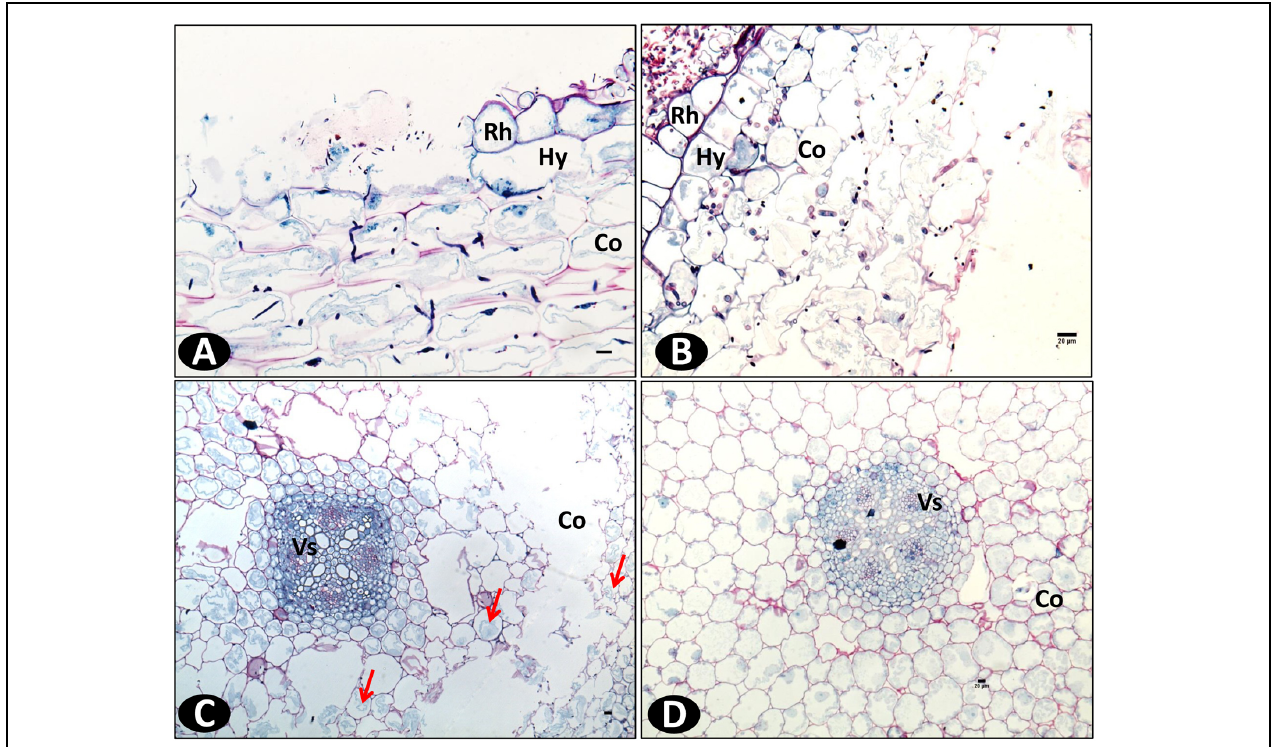
FIGURE 5 | Wide field microscopy images showing the colonization pattern of Fo072 in the in vitro roots of pla0001 double stained with Schiff reagent and Naphthol Blue-black at 7 dpi. Longitudinal section (A) and transverse section (B) of pla0001 showing the intercellular colonization of hyphae in the cortical region. (C) represents the transverse section of pla0001 showing the plasmolysis of cytoplasm from the cell walls and total collapse of the cortical region (Co) with flaccid cells, thereby disturbing the root architecture. The colonization is affected mostly at the cortex region whereas the vascular (Vs) cells remains uninfected. (D) Displays the transverse section of non-inoculated pla0001 where the cortical cells remains firm and complete. Rh: Rhizodermis and Hy: hypodermis. Scale bar = 20 μ m.